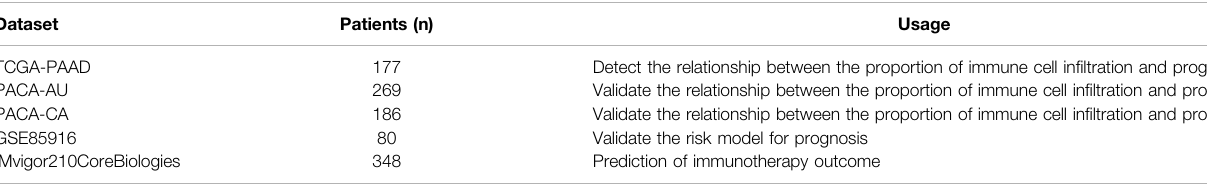
TABLE 1 | The information of data sets.